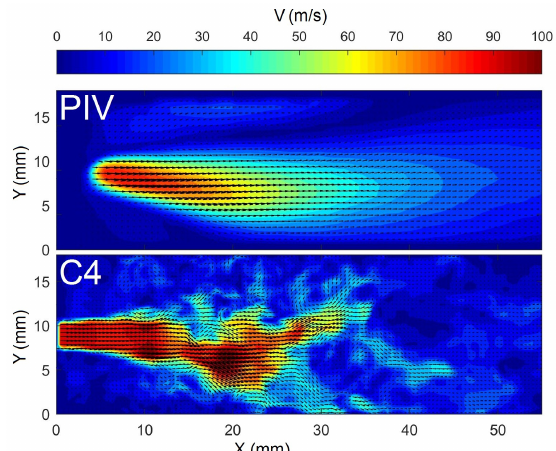
Figure 6. Planar velocity contours with vectors in the mid-coronal plane of the PIV measurement and case C4 at the middle of the oscillation cycle.